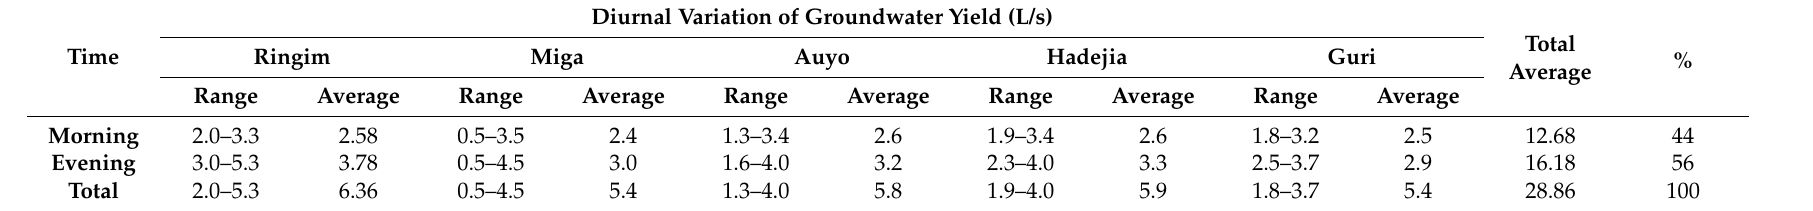
Table 3. Diurnal variation of groundwater yield along Hadejia River